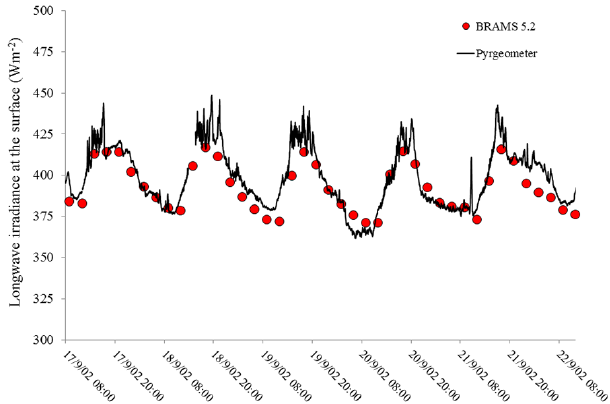
Figure 3. Time series of downwelling longwave irradiance (Wm − 2 ) at the Abracos Hill AERONET site during a cloudy pe- riod from 17 to 21 September 2002 from BRAMS 5.2 results. The black line refers to measurement data in the same